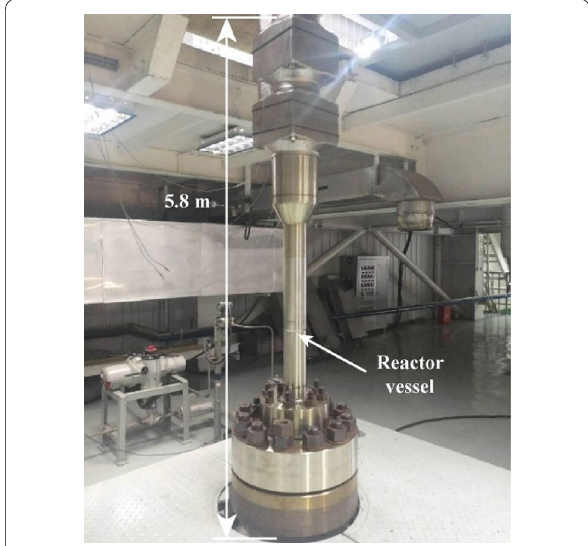
Figure 2 Experimental tester for movable latch in high temperature water